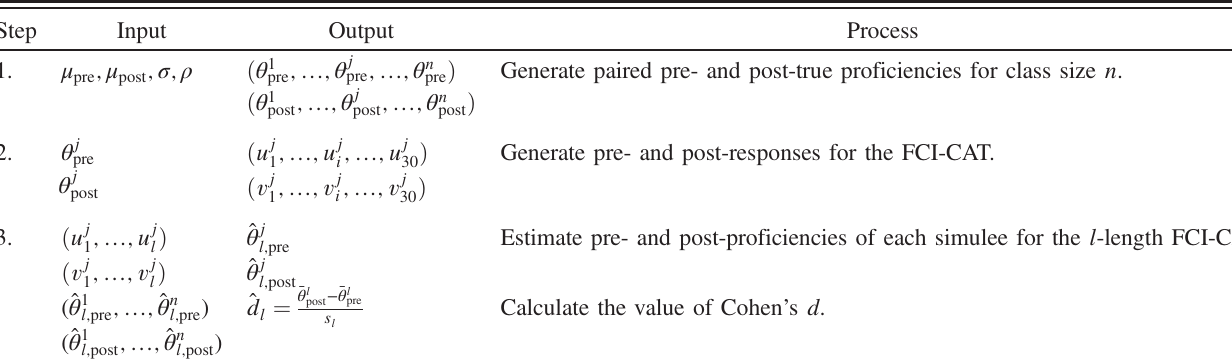
TABLE II. The first three steps of the Monte Carlo simulation described in Sec. II E. The designated population parameters are mean ( μ ), standard deviation ( σ ), and correlation ( ρ ). θ j is the true proficiency of the j th simulee. The i th response for j th simulee in the pre- and post- test ( u j and v j ) take values of 0 (incorrect) or 1(correct). i i are the mean and the pooled standard deviation of the estimated proficiencies of the l -length test for class size n